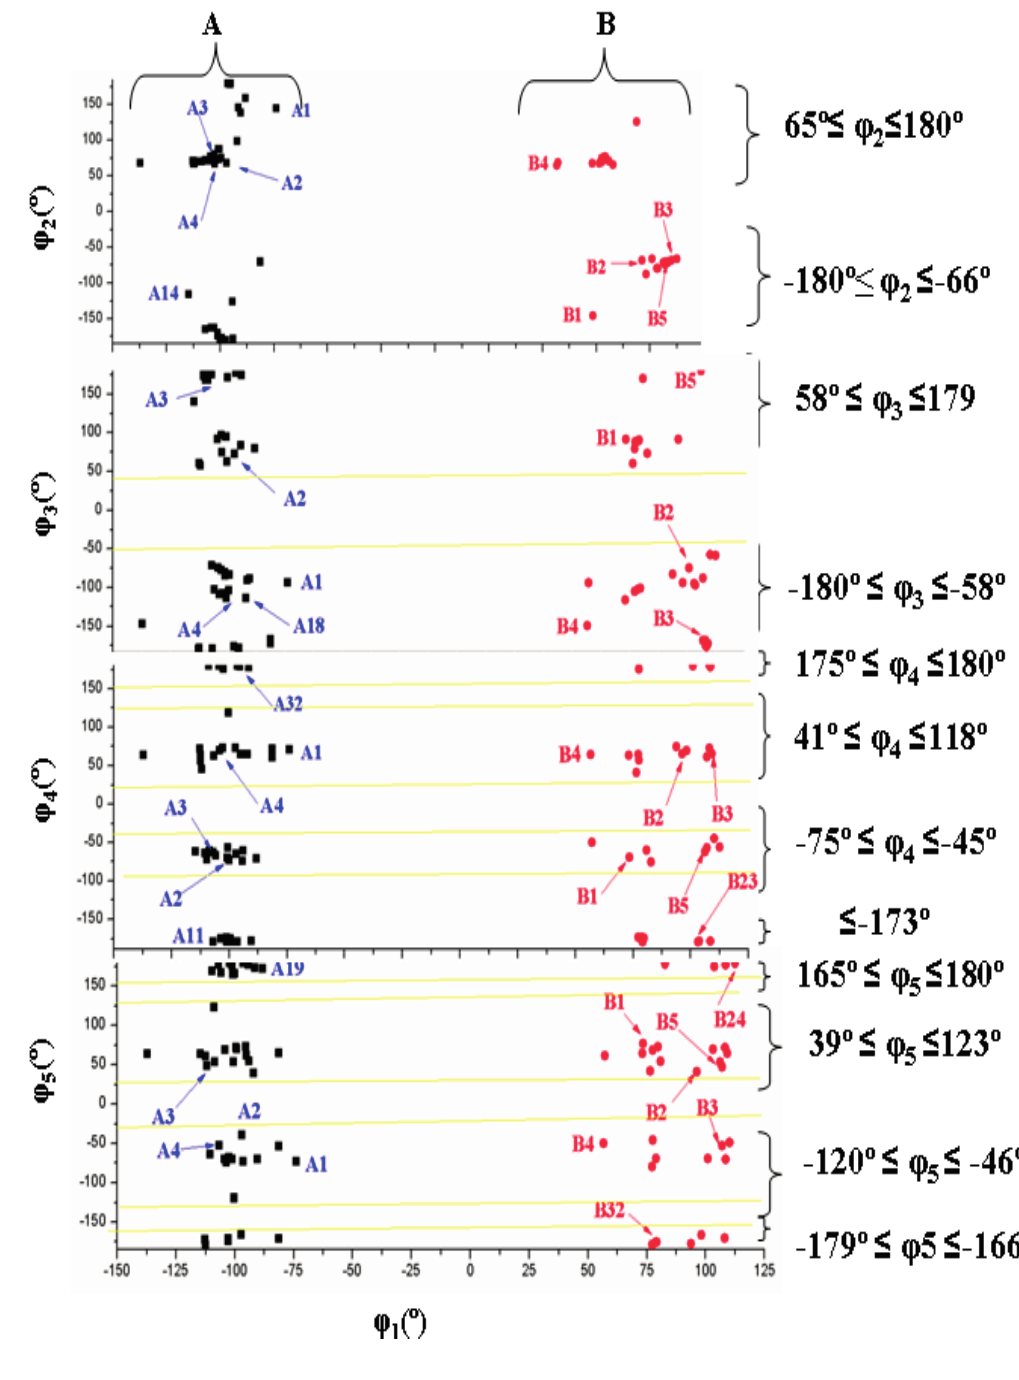
Figure 7. Distribution of the 78 optimum stable calculated conformers in tautomer N1 of acyclovir, according to the values of the exocyclic torsional angles: φ the angle φ 1